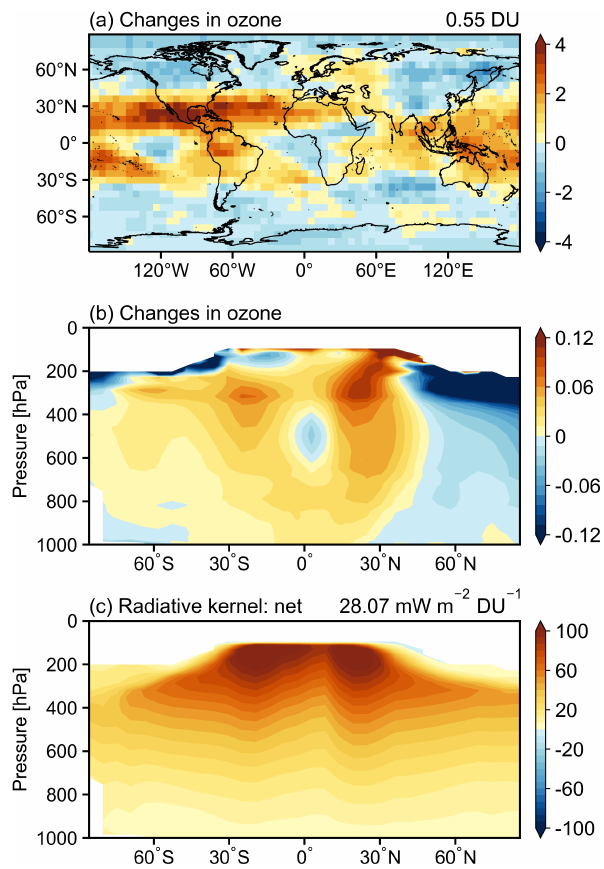
Figure 12. Changes in (a) annual mean tropospheric column ozone and (b) zonal-mean ozone between 2013–2017 and 1995–1999. (c) The values of the ozone radiative kernel (mWm − 2 DU − 1 ) for net forcing (LW + SW) from Skeie et al. (2020). The values of the annual global mean are shown in the upper